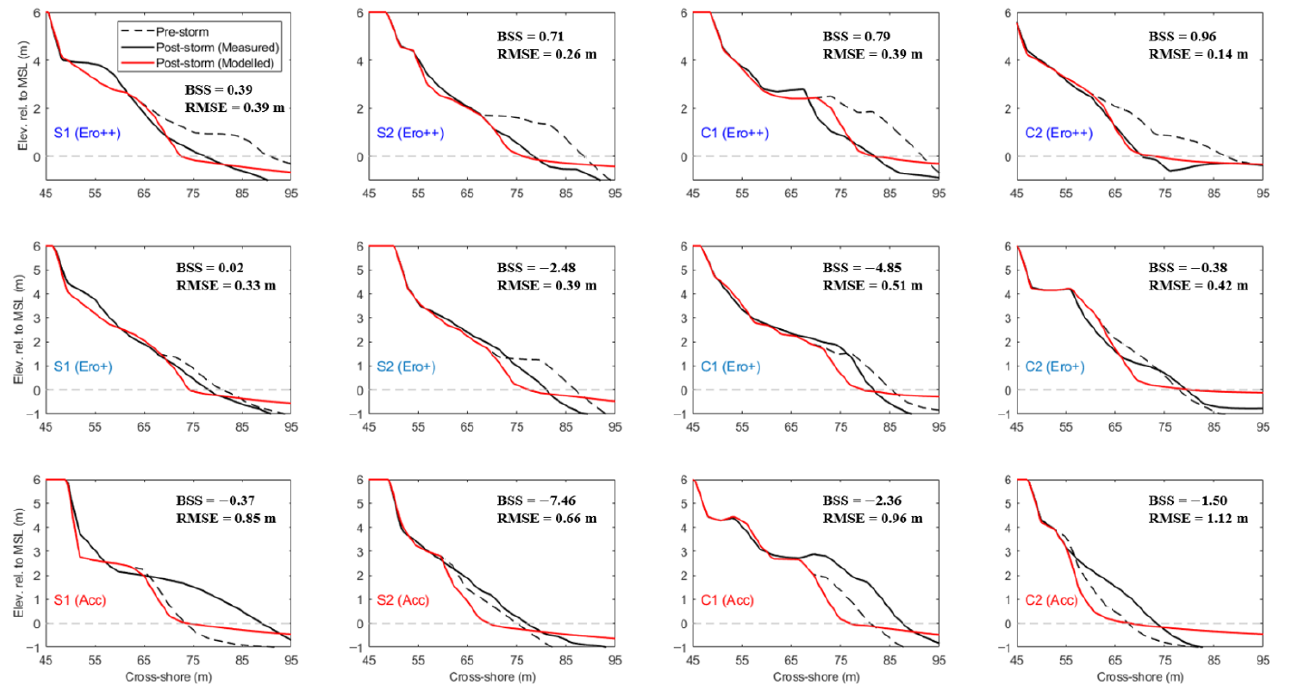
Figure 12. Model results of profile changes from the chosen parameter set ( facua = 0.15, alpha = 1, gamma = 0.52, and gamma2 = 0.3) under different storm conditions and initial beach widths. Ero++, Ero+, and Acc denote severe and mild erosion and accretion after storm events. BSS and RMSE are calculated by profile data above MSL.